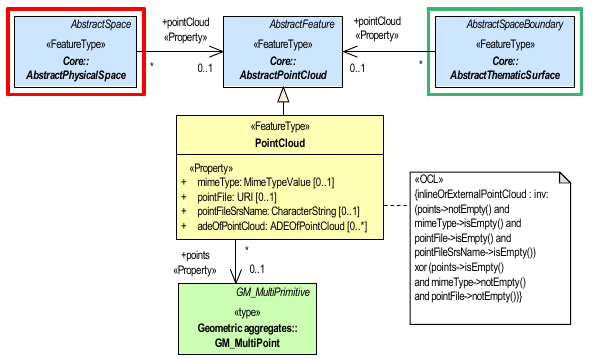
Figure 3. CityGML 3.0 PointCloud module (CityGML SWG,